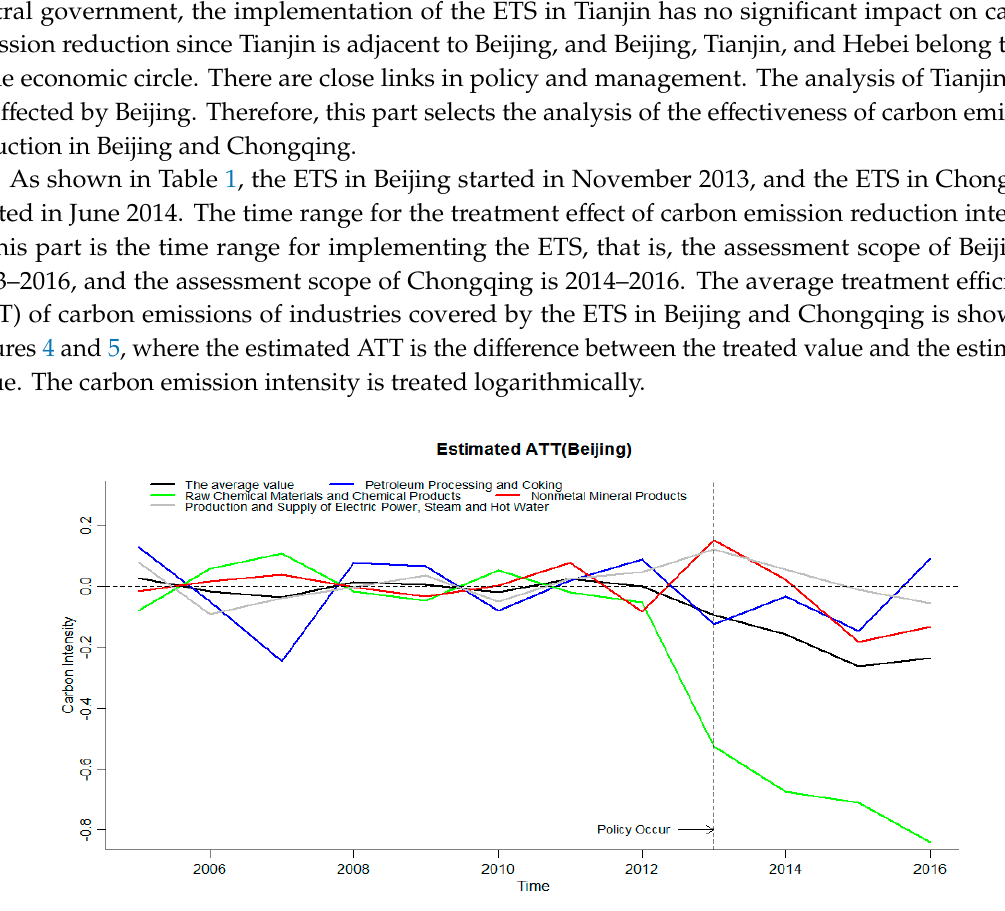
Figure 4. The impact of an ETS on industry carbon emission reduction rates in Beijing.